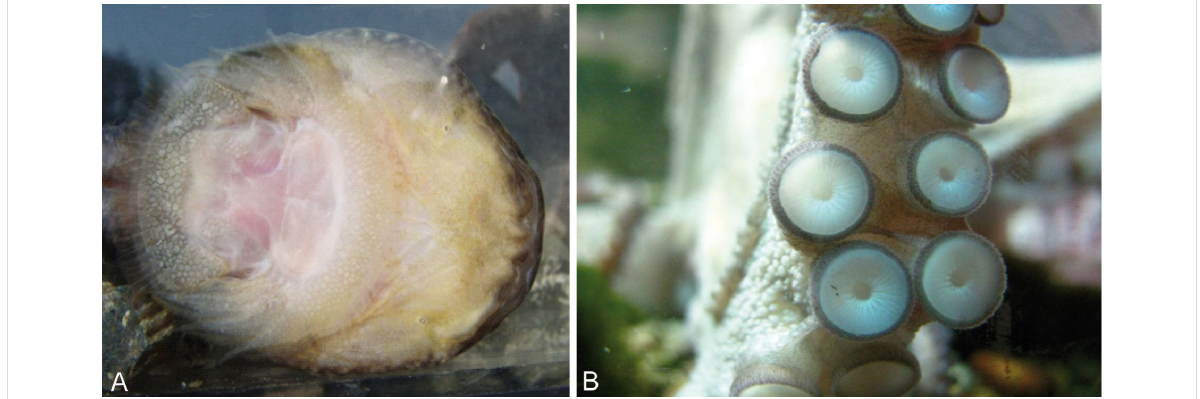
Figure 7: (A) Suction disc on the ventral side of Northern clingfish. Reproduced with permission from [27]. (B) Multiple suction discs on an octopus arm (image: Francesca Tramacere).